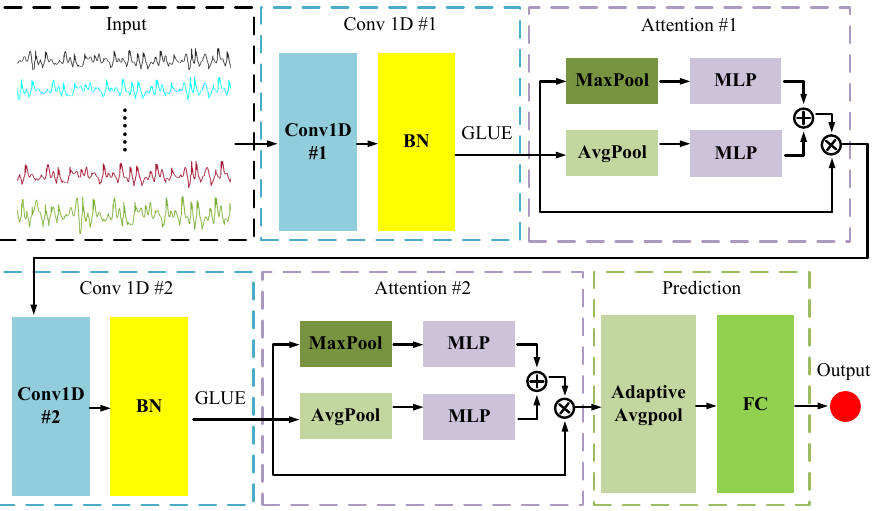
Figure 1. The network architecture of the propose approach. The inputs are K measurements in the time domain. The convolution modules are utilized for feature extraction, while the attention module are used for feature weighting. The final prediction module would map the learned features to the dynamic load for a certain time